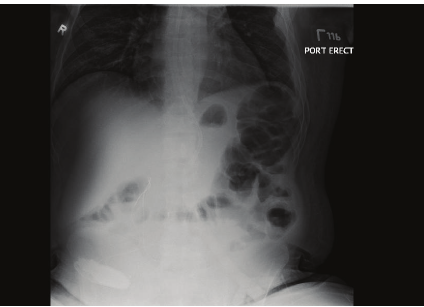
Figure 2: Portable chest radiograph demonstrating jejunostomy tube extending retrograde through esophagus, with no evidence of perforation.